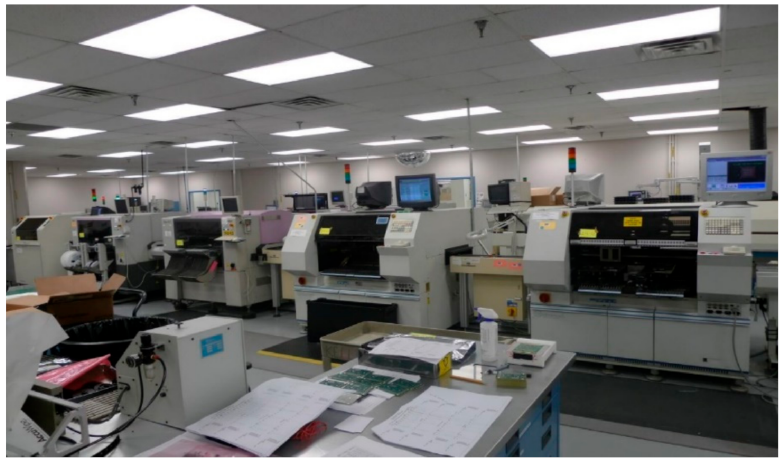
Figure 2. Assembly line at